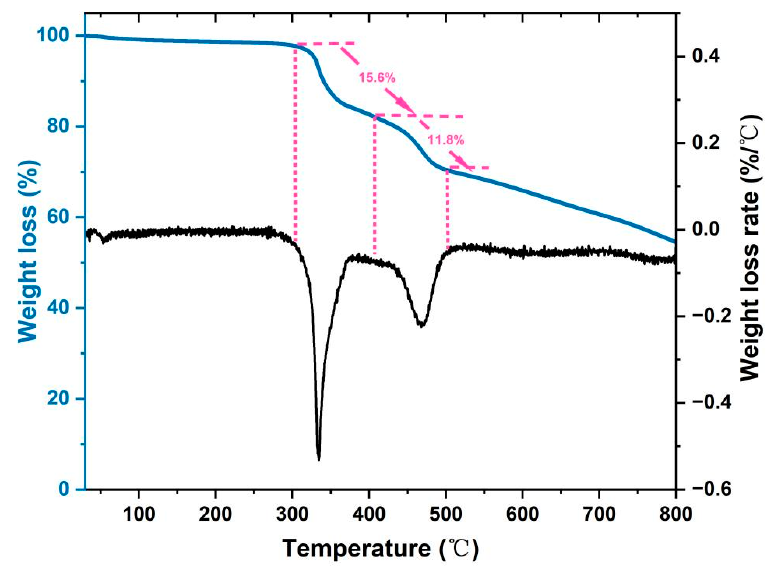
Figure 3. TG and DTG curves of [Yb(DPPDA) 2 ](DIPEA) at a heating rate of 10